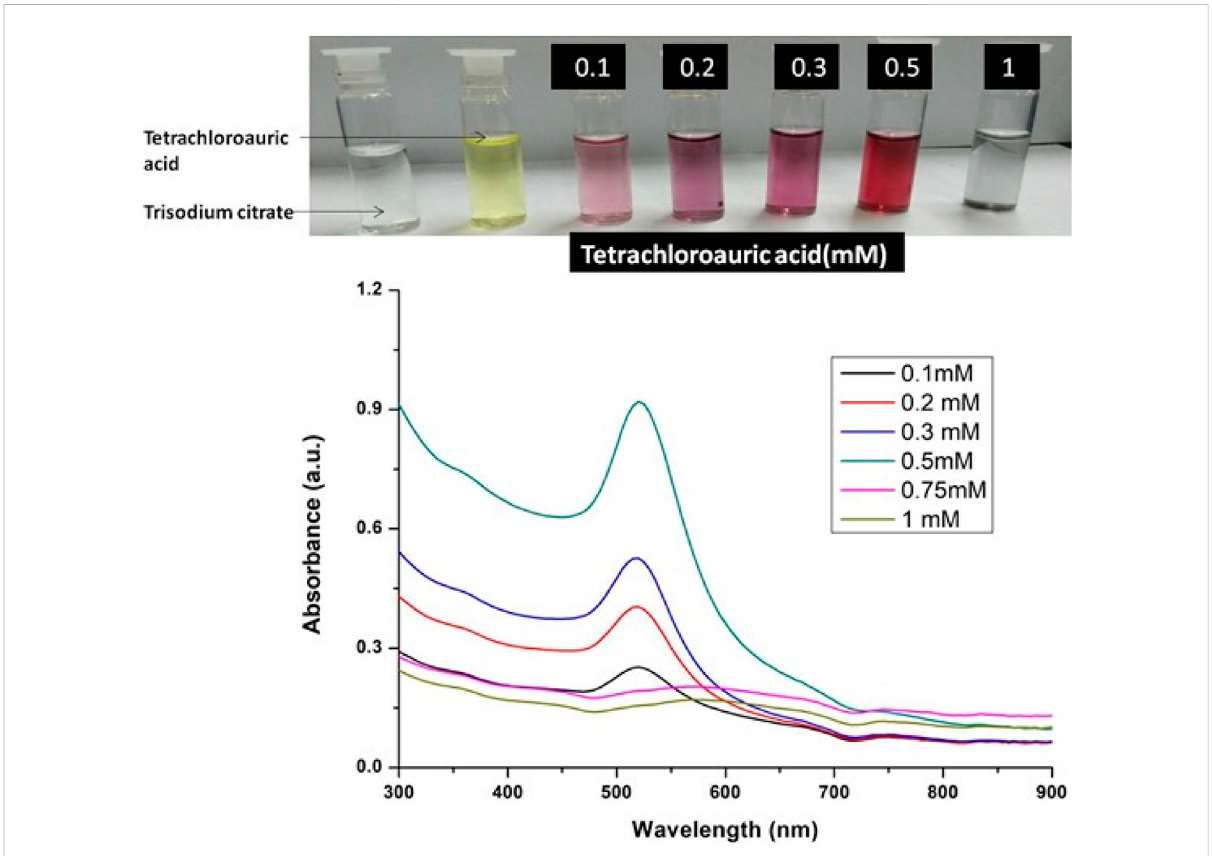
FIGURE 1 UV-Vis Spectra of Gold nanoparticles solutions synthesised by varying concentrations of tetrachloauric acid. The experiments were done in triplicate and results within each pair differed by <